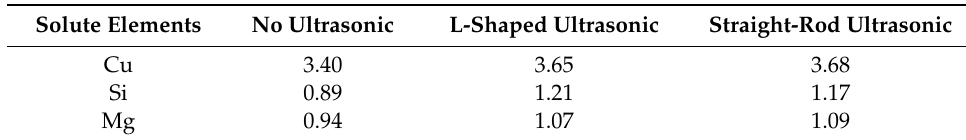
Figure 10. Results and areas of line scan analysis of main alloy elements in the ingots under di ff erent processing conditions: ( a ) No ultrasonic treatment; ( b ) treatment by the L-shaped ultrasonic wave guide rod; and ( c ) treatment by the straight-rod ultrasonic wave guide rod. Table 3. Content of solute elements in the α -Al matrix structure of the ingots treated under di ff erent processing conditions